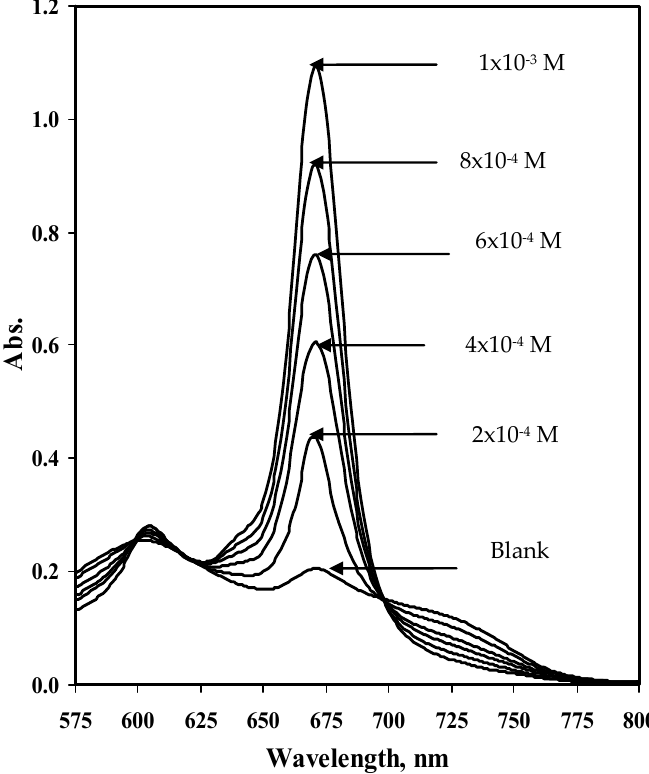
Figure 1. Absorption spectra of sulfite calibrants in the range of 2 × 10 − 4 to 1 × 10 − 3 M after the addition of 1 mL of 0.1 mg/mL CoPC in DMSO.